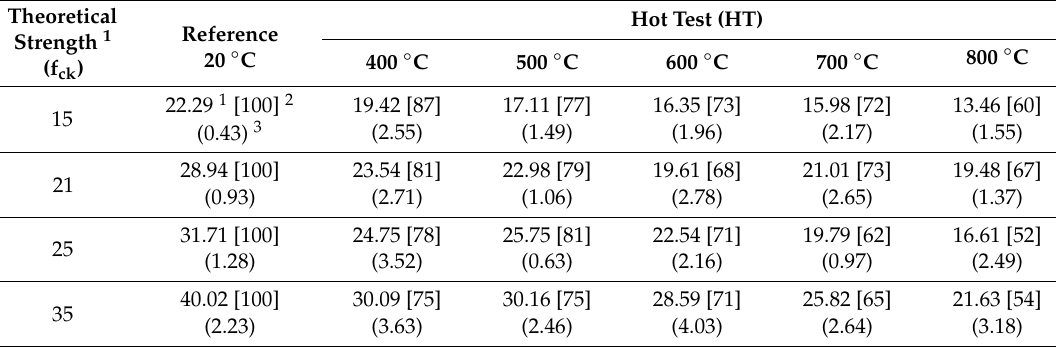
Table 2. Results of the compressive strength for hot